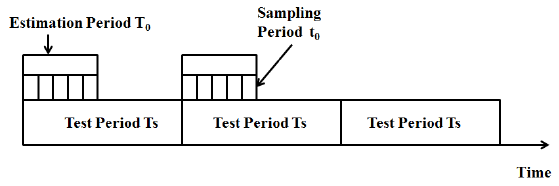
Figure 3. The time model of